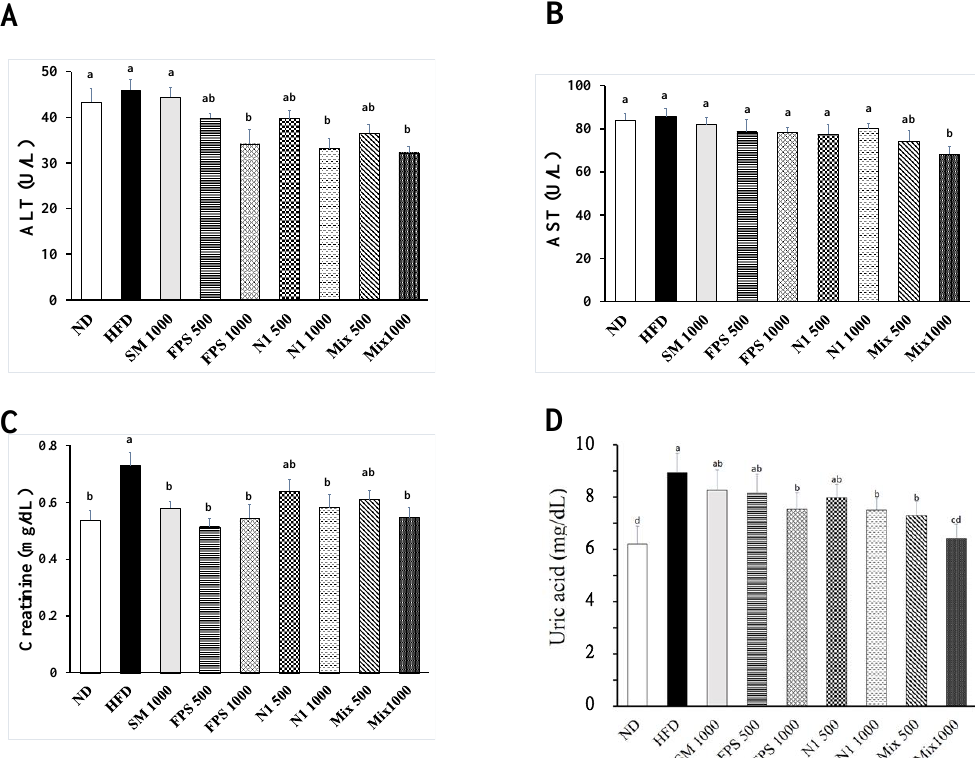
Figure 5. Evaluation of the impact of fermented SBM on hepatic and nephritic function. The rats were fed an HFD for 10 weeks, followed by various fermented SBM products for 6 weeks. The blood samples of rats were individually harvested to examine the plasma levels of ( A ) alanine aminotransferase (ALT), ( B ) aspartate aminotransferase AST, ( C ) creatinine, and ( D ) uric acid, using commercial kits. Results are expressed as a mean ± standard deviation for each group of rats ( n = 8). Different letters (a – d) indicate the statistical difference ( p < 0.05) between each group.